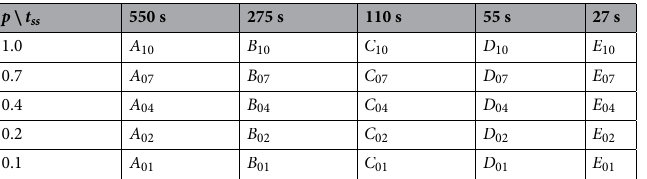
E c E d E c E d E c 10 / 01 - 10 / 01 - 10